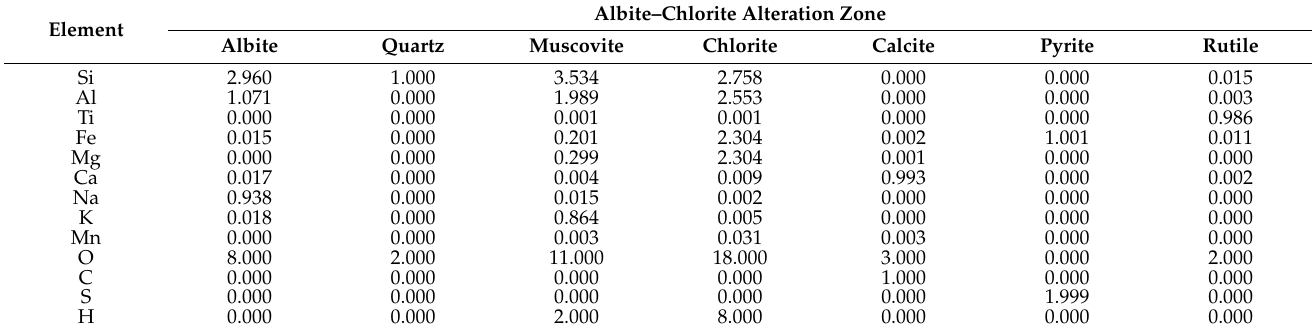
Table 4. Mineral formulae calculated from electron microprobe analysis used for the balanced mineral reactions of albite–chlorite alteration zone.